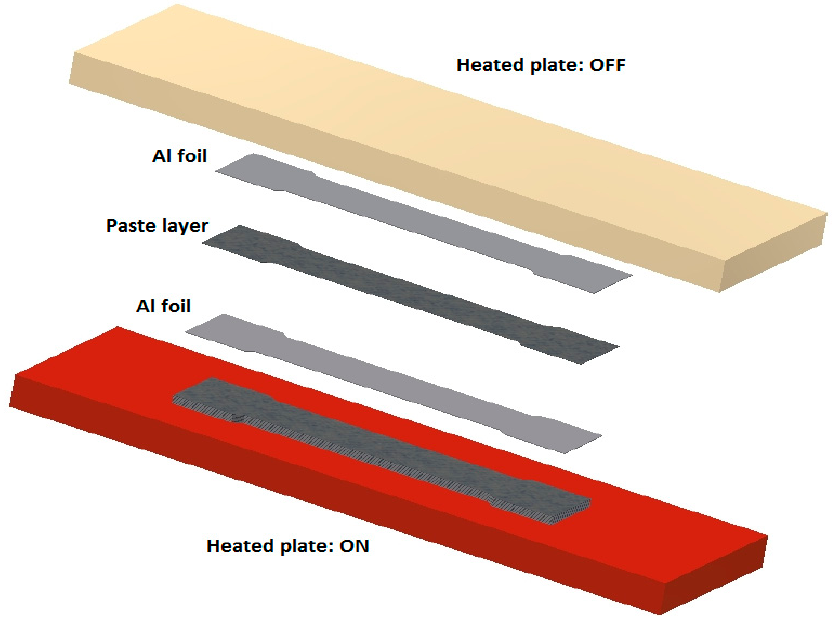
Figure 1. Elements of transient thermal analysis.